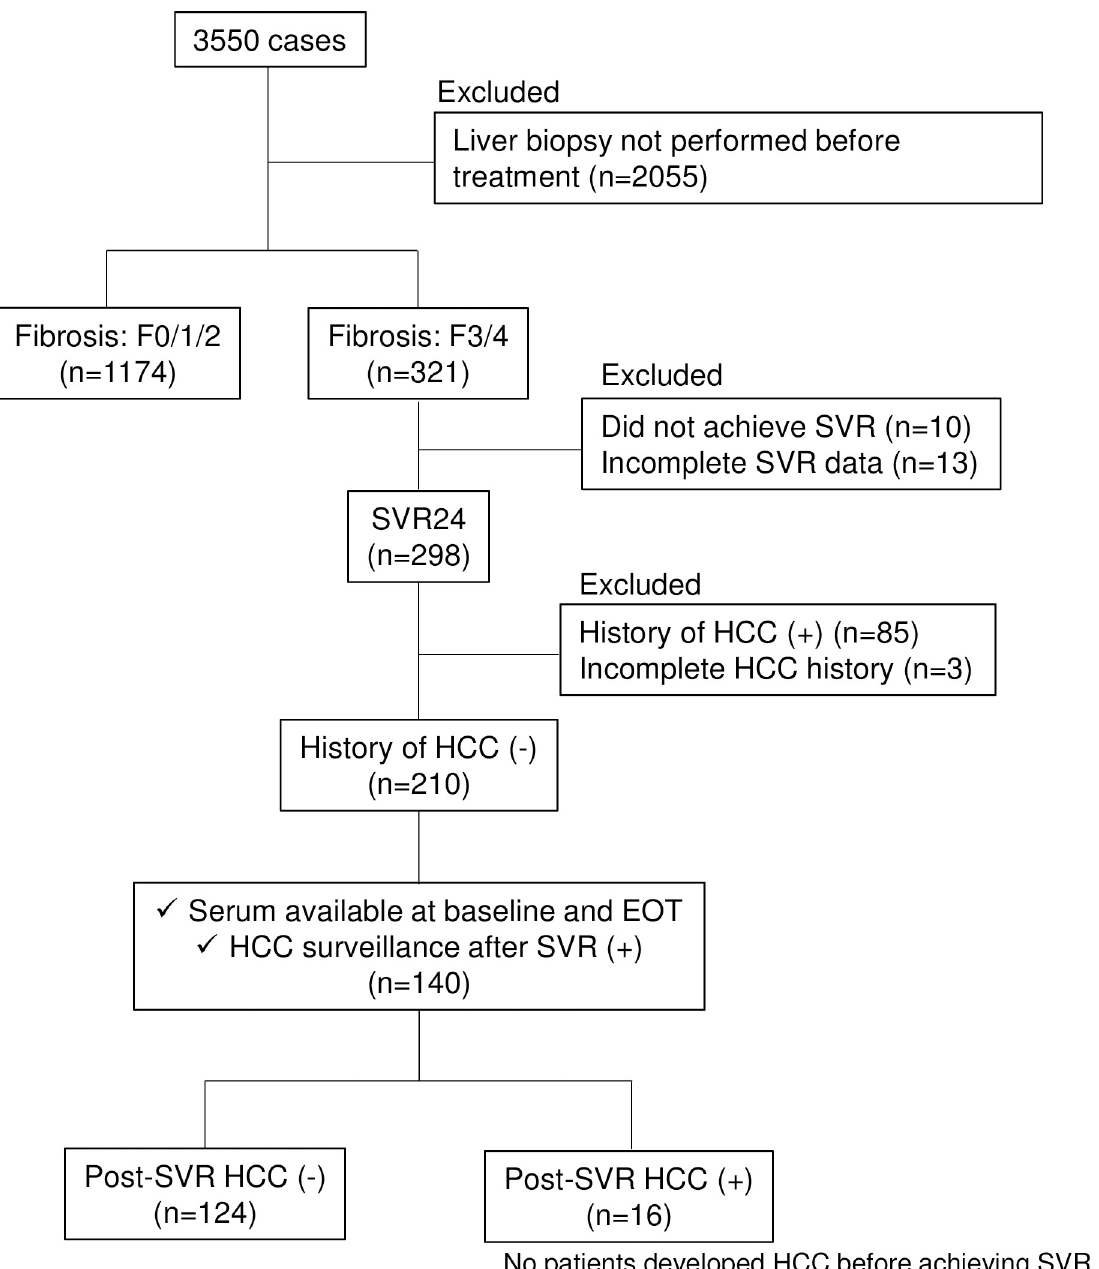
Fig 1. Study flowchart for enrollment in this study. Abbreviations: EOT, end of treatment; HCC, hepatocellular carcinoma; SVR, sustained virological response.